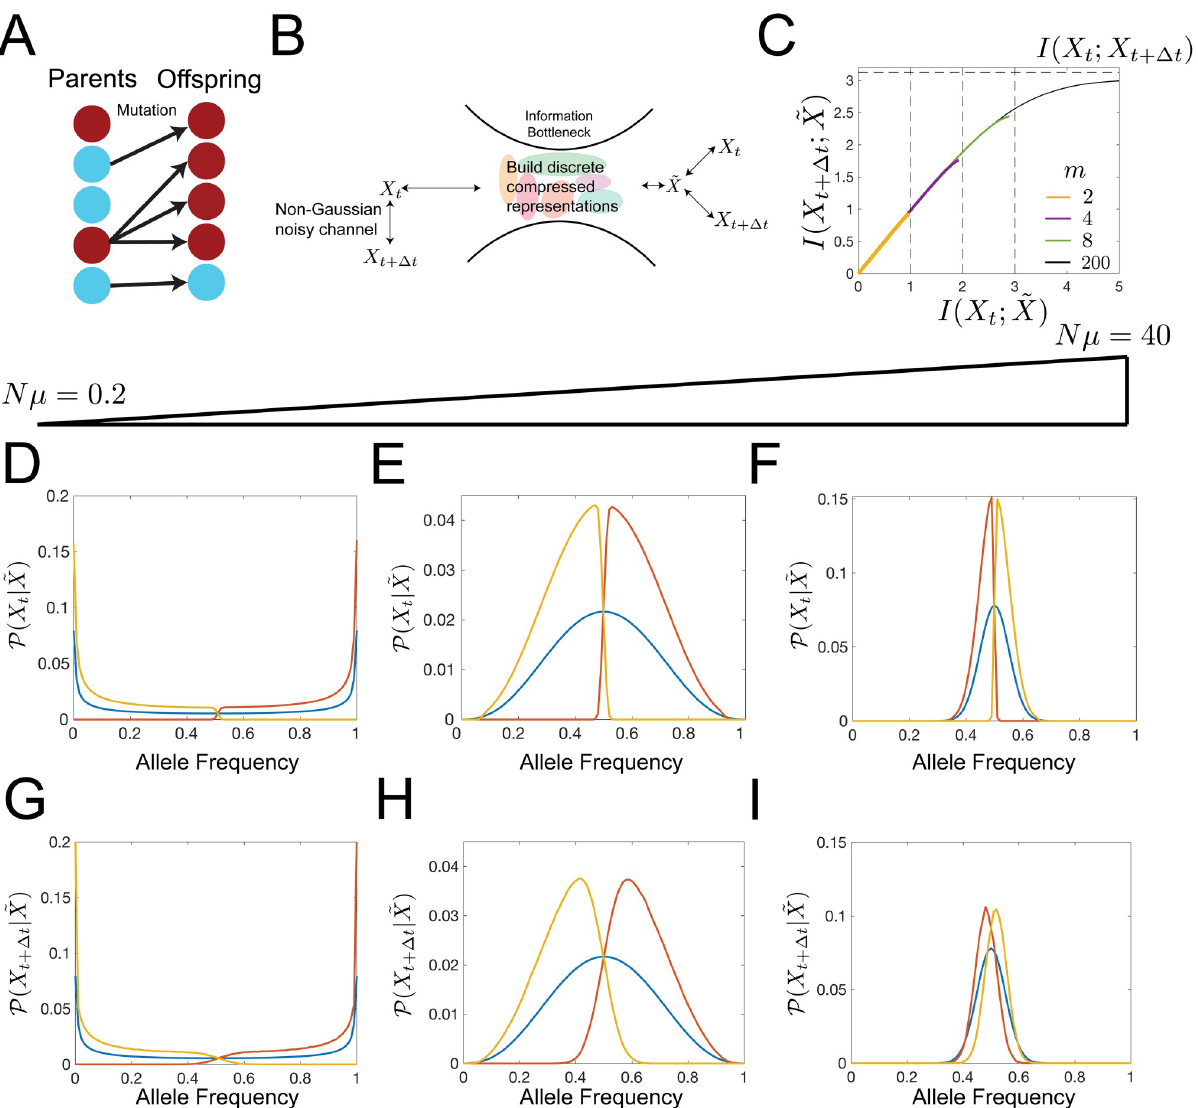
Fig 8. The information bottleneck solution for a Wright Fisher process. (a) The Wright-Fisher model of evolution can be visualized as a population of N parents giving rise to a population of N offspring. Genotypes of the offspring are selected as a function of the parents’ generation genotypes subject to mutation rates, μ , and selective pressures s . (b) Information bottleneck schematic with a discrete (rather than continuous) representation variable, ~ X . (c) Predictive information as a function of compression level. Predictive information increases with the cardinality, m , of the representation variable. The amount of predictive information is limited by log( m ) (vertical dashed lines) for small m , and the mutual information between allele frequencies at time t + Δ t and time t , I ( X t + Δ t ; X t ) (horizontal dashed line), for large m . Bifurcations occur in the amount of predictive information. For small I ð X ; ~ X Þ , t the encoding strategies for different m are degenerate and the degeneracy is lifted as I ð X ; ~ X ) increases, with large m schemes accessing higher I ð X ; ~ X Þ t t ranges. Parameters: N = 100, Nμ = 0.2, Nμ = 0.2, Ns = 0.001, Δ t = 1. (d-i) We explore information bottleneck solutions to Wright-Fisher dynamics under the condition that the cardinality of ~ X , m , is 2 and take β to be large enough that I ð X ; ~ X Þ � 1 , β � 4. Parameters: N = 100, Ns = 0.001, Δ t = 1, and Nμ = t 0.2, Nμ = 2, and Nμ = 40 (from left to right). (d-f) In blue, we plot the steady state distribution. In yellow and red, we show the inferred historical distribution of alleles based on the observed value of ~ X . Note that each distribution is corresponds to roughly non-overlapping portions of allele frequency space. (g-i) Predicted distribution of alleles based on the value of ~ X . We observe that as mutation rate increases, the timescale of relaxation to steady state decreases, so historical information is less useful and the predictions becomes more degenerate with the steady state distribution.